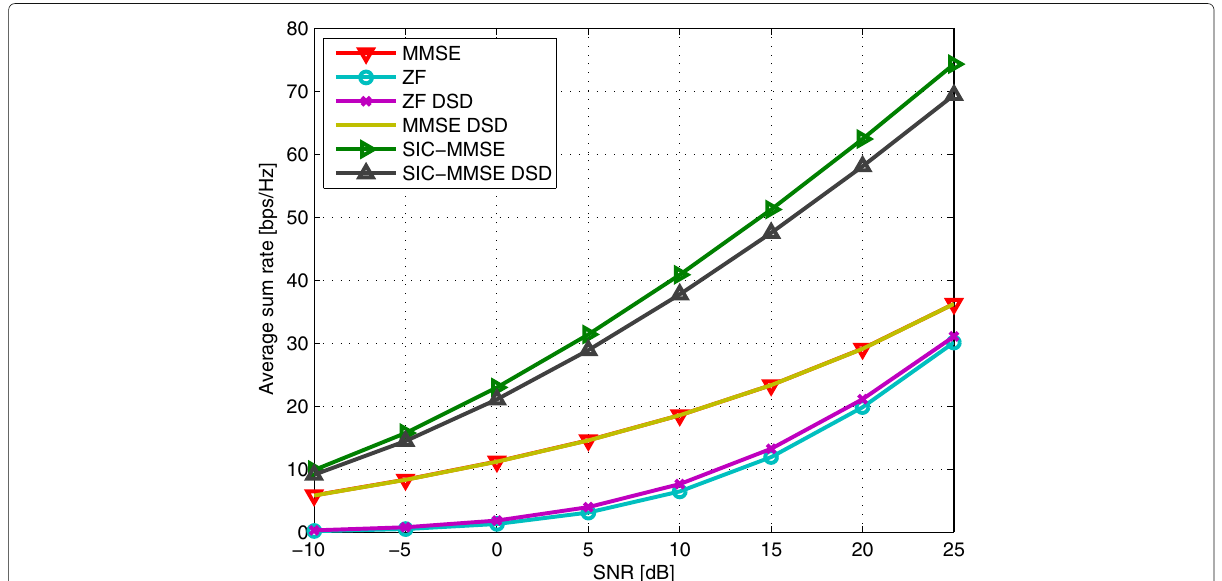
= 8 antennas per user. We consider DAS configuration with N k , n